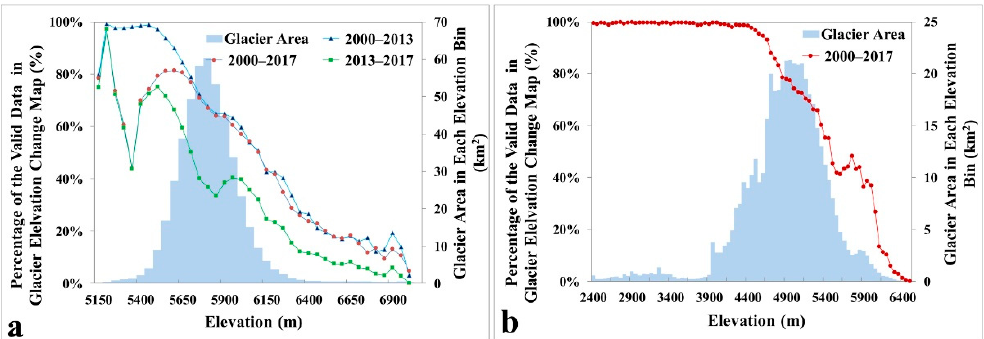
Figure 7. The percentage of valid data in the glacier elevation change maps and glacier area versus elevation in the both study areas ( a ) WNM; ( b ) ENM.